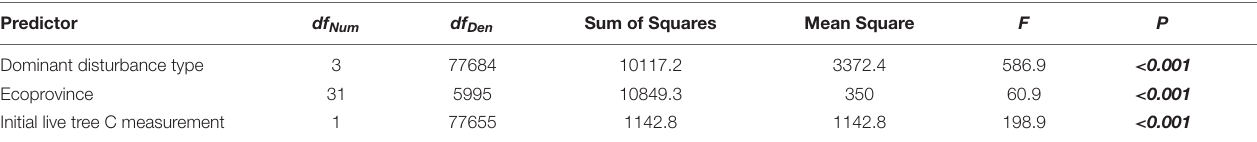
TABLE 1 | Fixed effect analysis of variance results for linear models of average annual change in live tree C sequestration capacity (Mg C ha − 1 yr − 1 ) showing predictor variables, numerator, and denominator degrees of freedom, sum of squares, mean squares, F statistics, and unadjusted P -values. Predictor df Num df Den Sum of